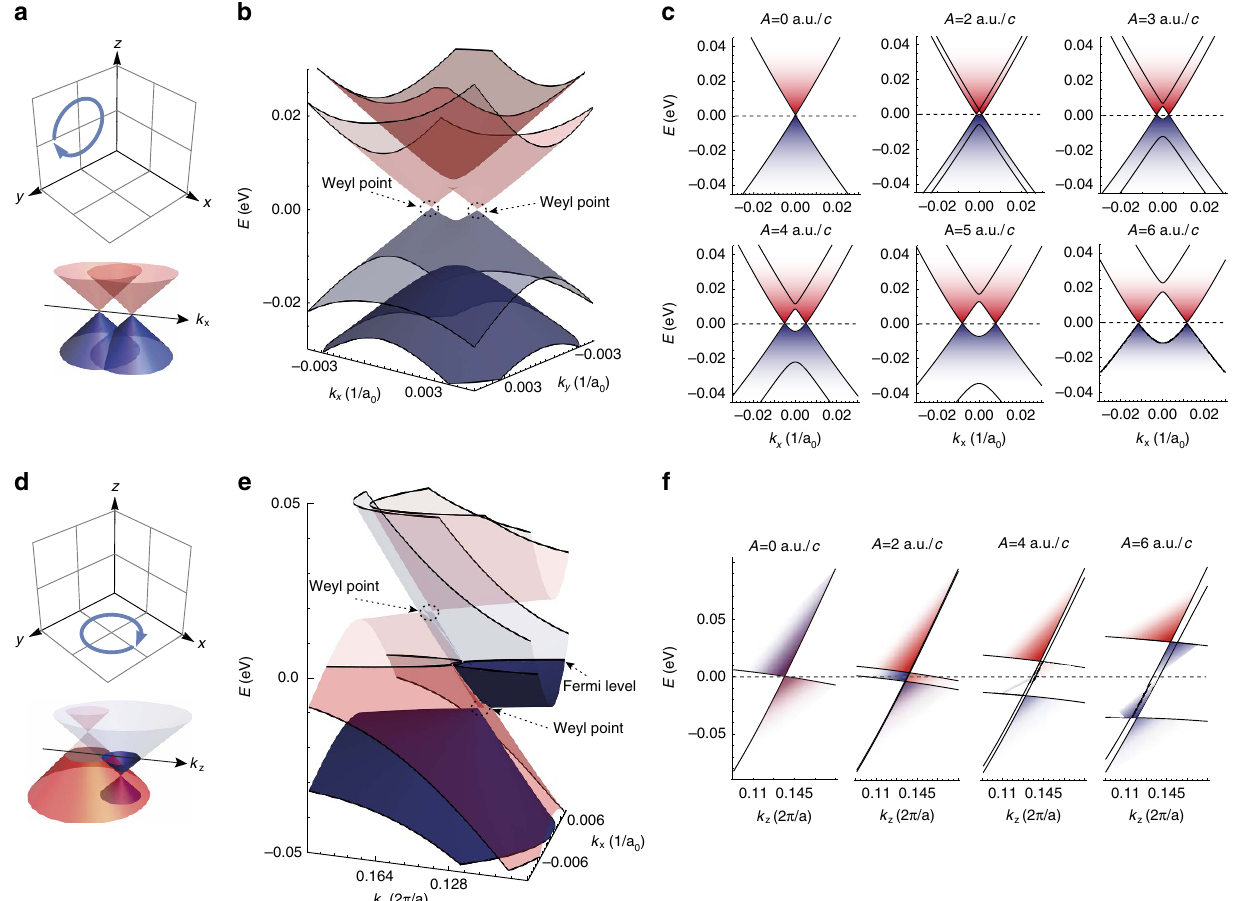
Figure 2 | Polarization control of Floquet–Weyl point splitting. ( a ) Circularly polarized light in the y – z -plane splits Floquet–Weyl points along the k x direction at the Fermi level, resulting in a Floquet–Weyl semimetal. ( b ) The Floquet–Weyl points form 3D cones in the Brillouin zone. An example in the k x – k y -plane is shown for amplitude A ¼ 3 a.u./ c . ( c ) The splitting of the Floquet–Weyl points increases with the intensity (amplitude) of the driving